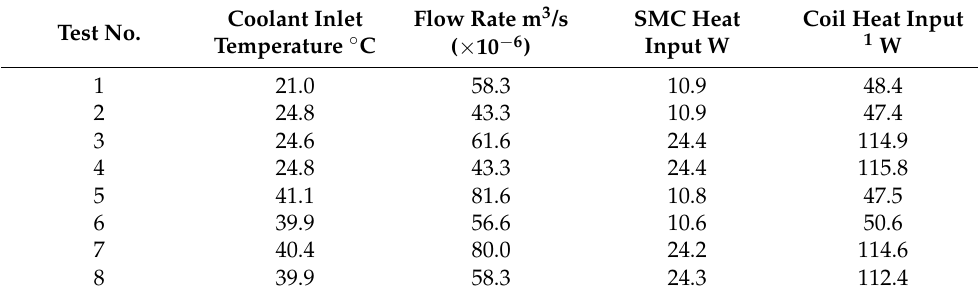
Table 6. Transient calibration of the conventional windings. Test No.